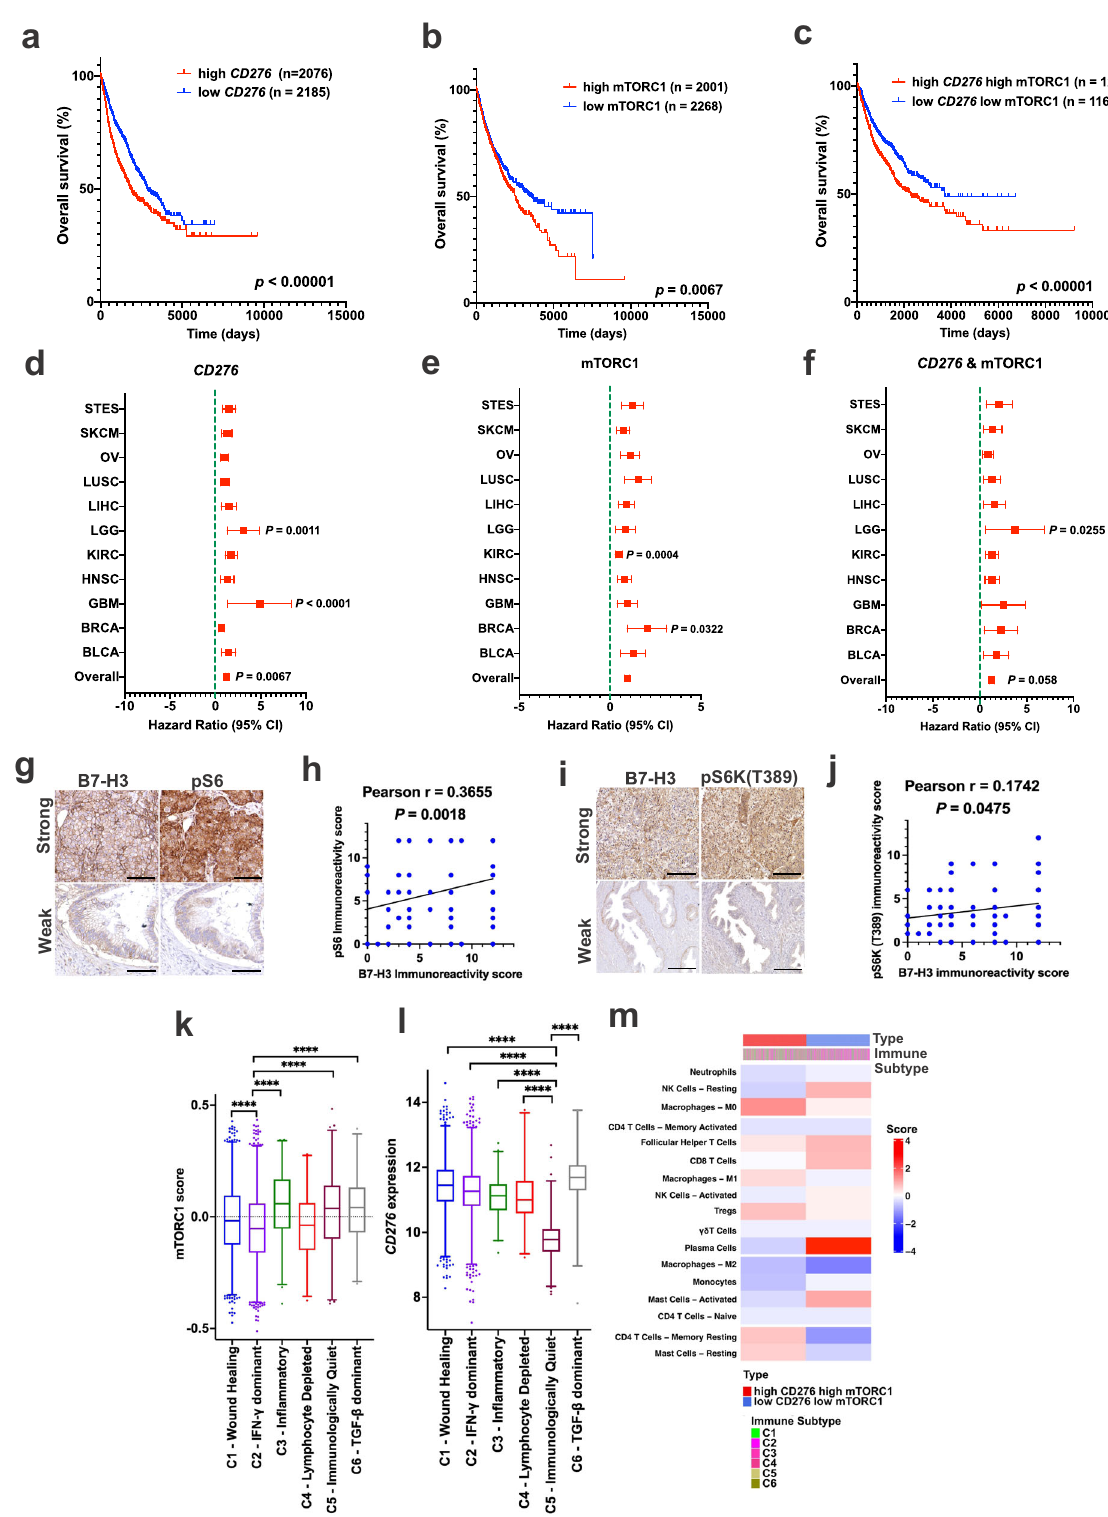
Cd276 promoterishigherinTsc2-de fi cientcells,witha6-fold( p <0.01) increase in Tsc2-null 105K and a 2-fold ( p < 0.01) in Tsc2 KO MEFs compared to controls (Fig. 3j, k). Downregulation of YY2 using siRNA suppressed CD276 promoter activity by <50% in both Tsc2-de fi cient 105K cells and Tsc2 KO MEFs (Fig. 3l, m). Together, these data indicate that YY2 upregulates CD276 transcription in cells with hyperactive